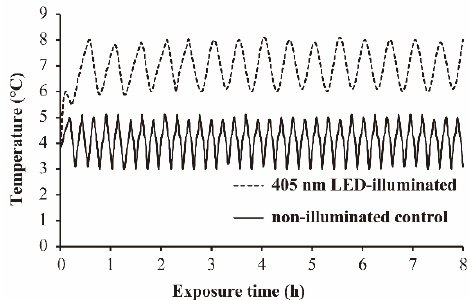
Figure 1. Temperature profile on beef slice during 405 nm LED-irradiation at 4 °C.